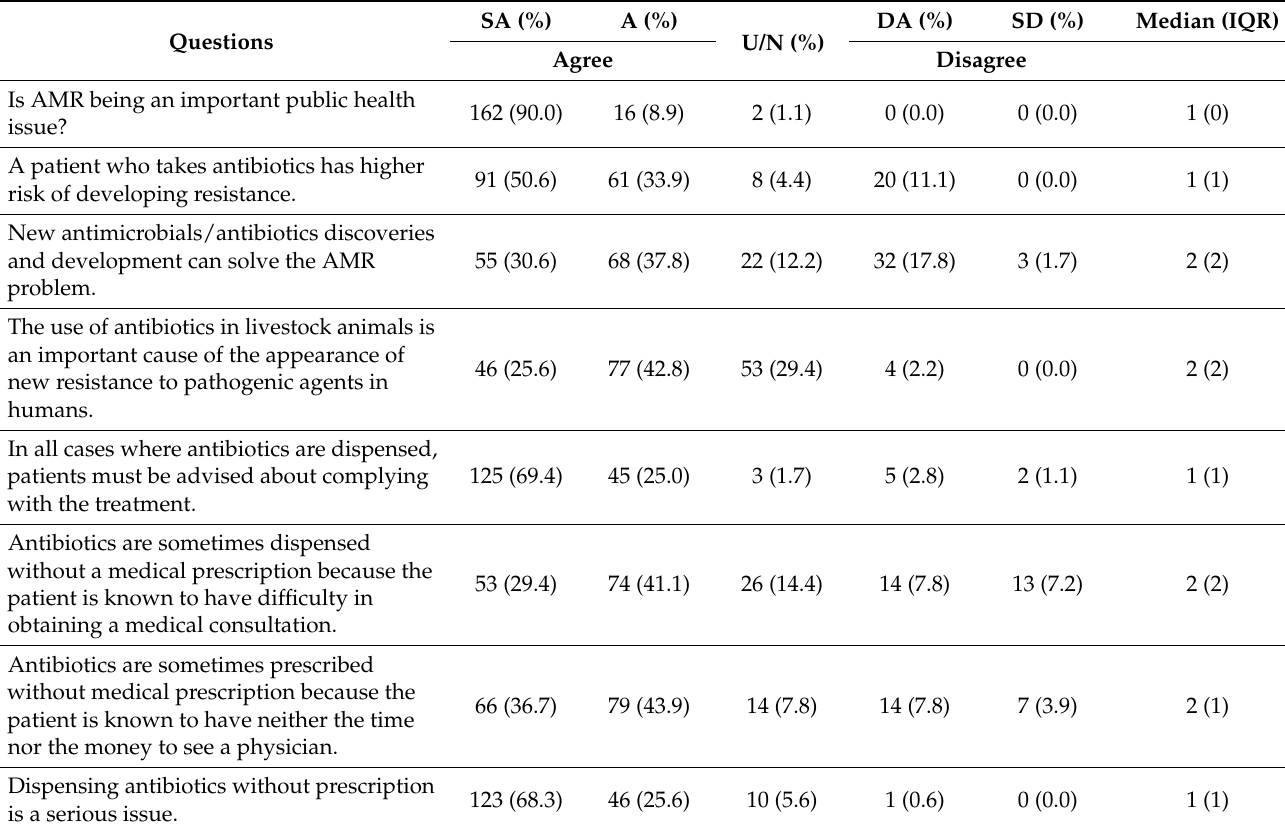
Table 3. Attitude of respondents about antimicrobial stewardship programs